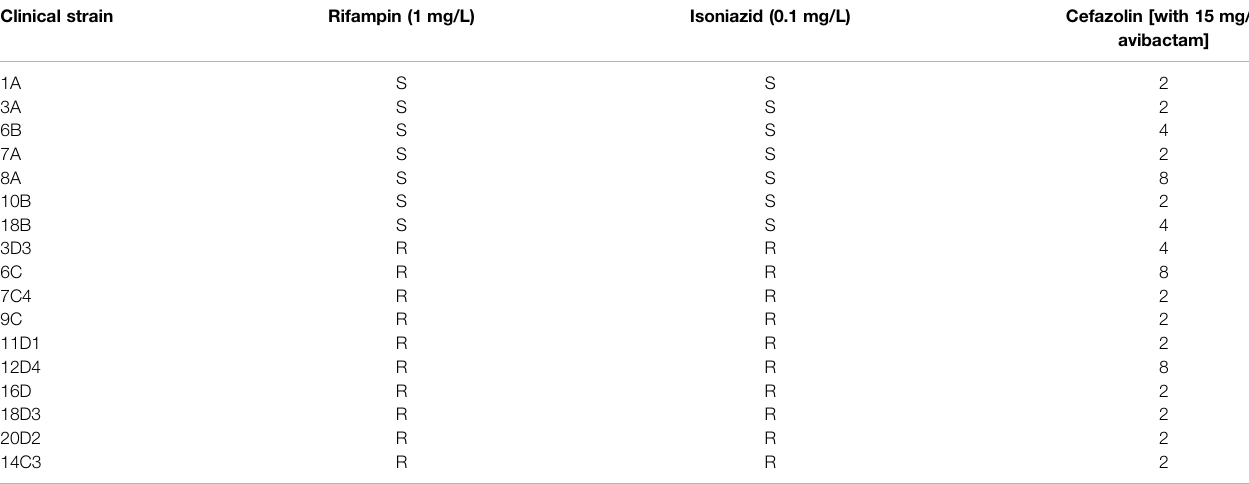
TABLE 2 | Cefazolin MIC distribution among M. tuberculosis clinical isolates. Isoniazid and rifampin were used at a single drug concentration to recon fi rm the drug- susceptible or MDR-TB status. Cefazolin MIC 50 (in combination with avibactam) for the clinical isolates was 2 mg/L, whereas MIC 90 was calculated as 8